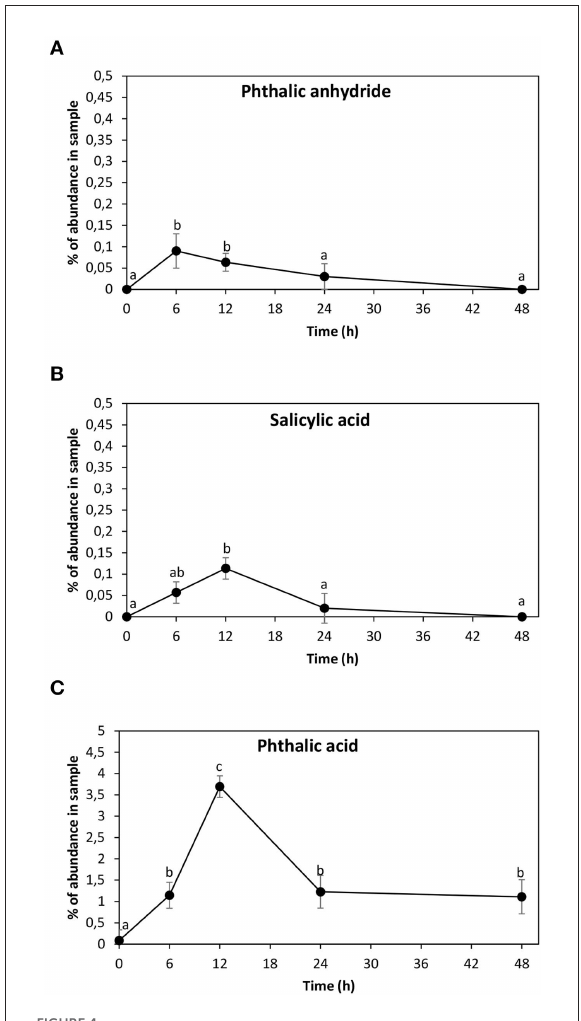
FIGURE4 Level of anthracene (ANT) metabolites corresponding to phthalic anhydride (A) , salicylic acid (B) , and phthalic acid (C) . The level of each metabolite is expressed in percentage of abundance in the sample injected into GC–MS column. Symbols represent the mean value of three independent experiments. Different letters indicate significant differences among mean values ( ± SD) ( p <